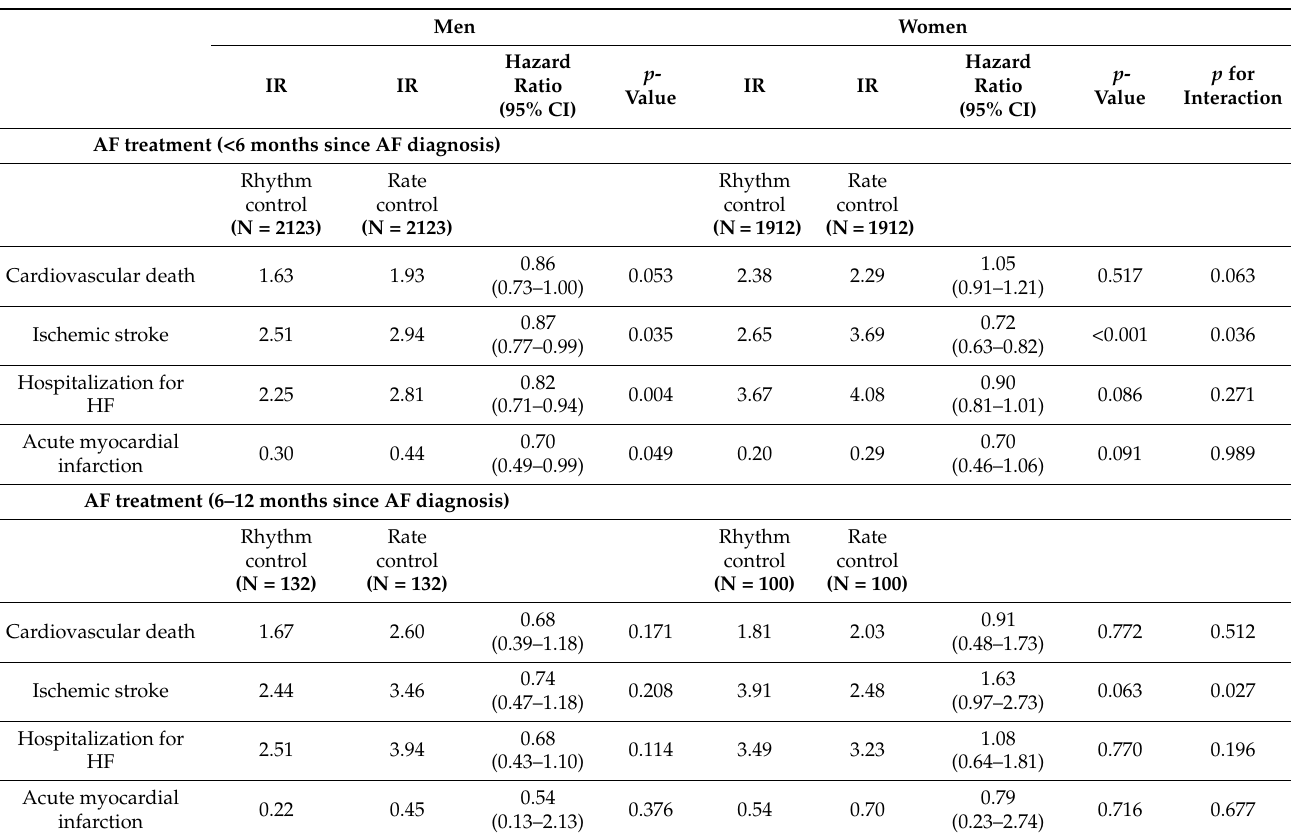
Table 4. Relative effect of rhythm control over rate control on individual components of the primary composite outcome after overlap